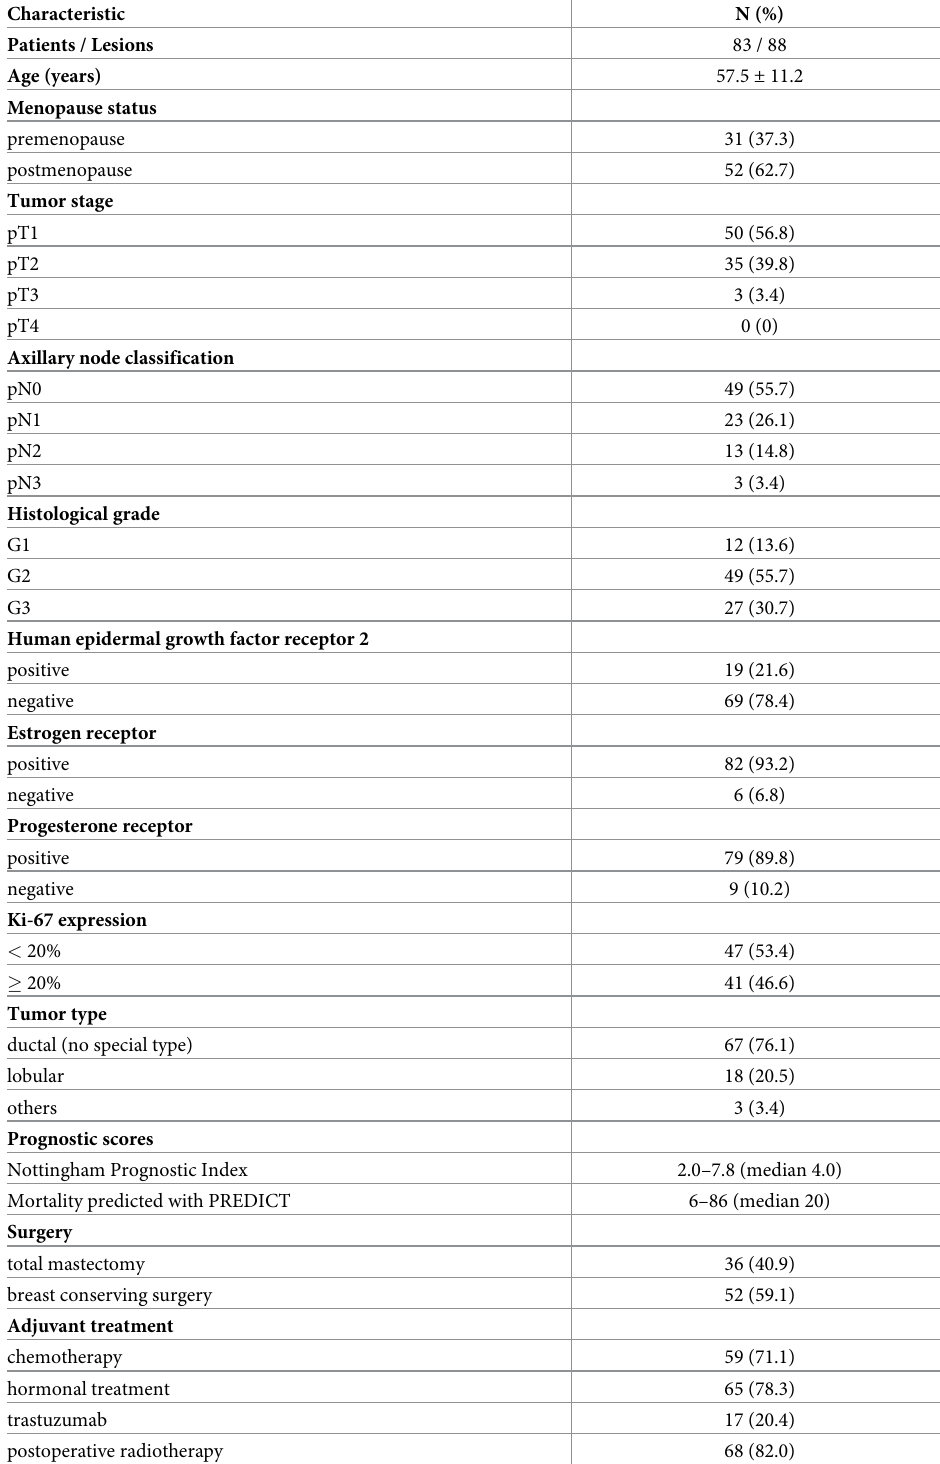
Table 2. Patient profiles and tumor